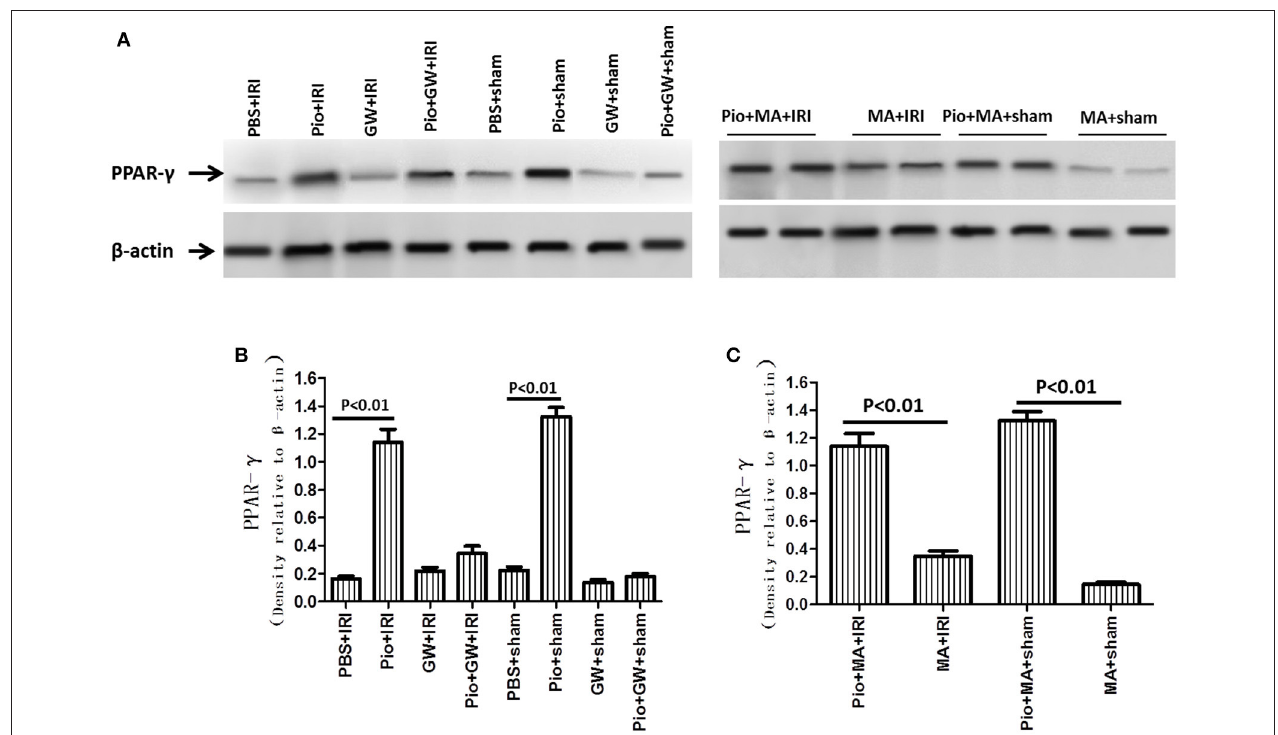
FIGURE 6 | Pioglitazone increases PPAR- γ protein expression. (A) Representative western blots show PPAR- γ protein level in the kidneys at 24h after renal IRI. (B,C) Quantitative analysis of PPAR- γ protein level in the kidneys. Values are expressed as means ± SE. n = 6 in each group. PPAR- γ , peroxisome proliferators-activated receptor- γ